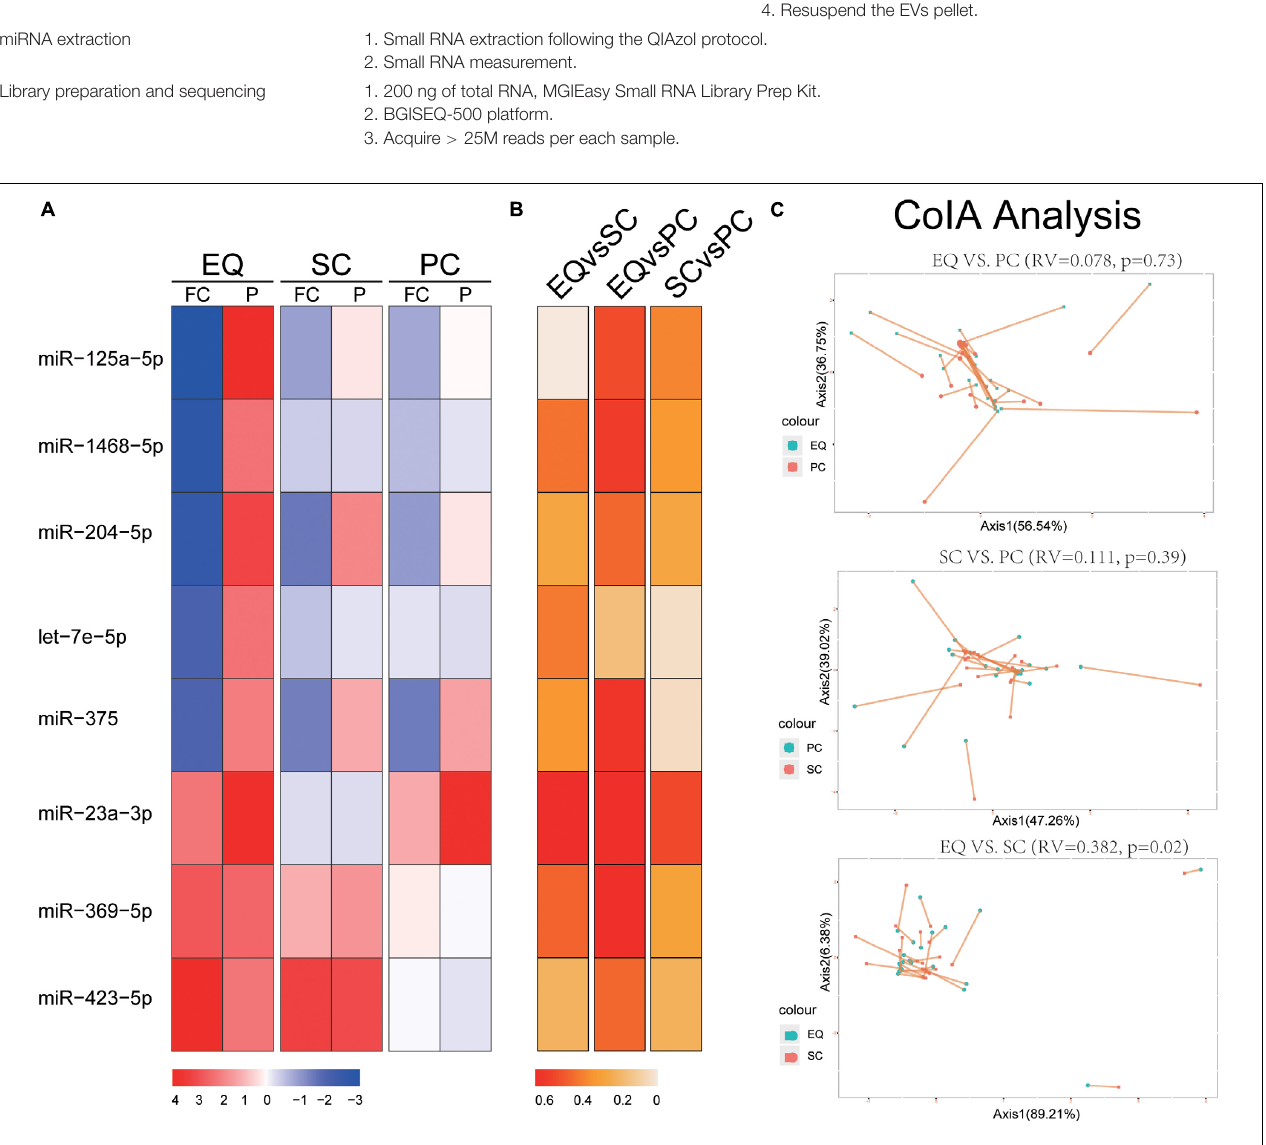
Human Brain Reference RNA (HBRR) samples were added into sRNA libraries as external markers in order to eliminate the bias of each sequencing lane. It was observed that over 20 million reads per sample were mapped to human genome, and most